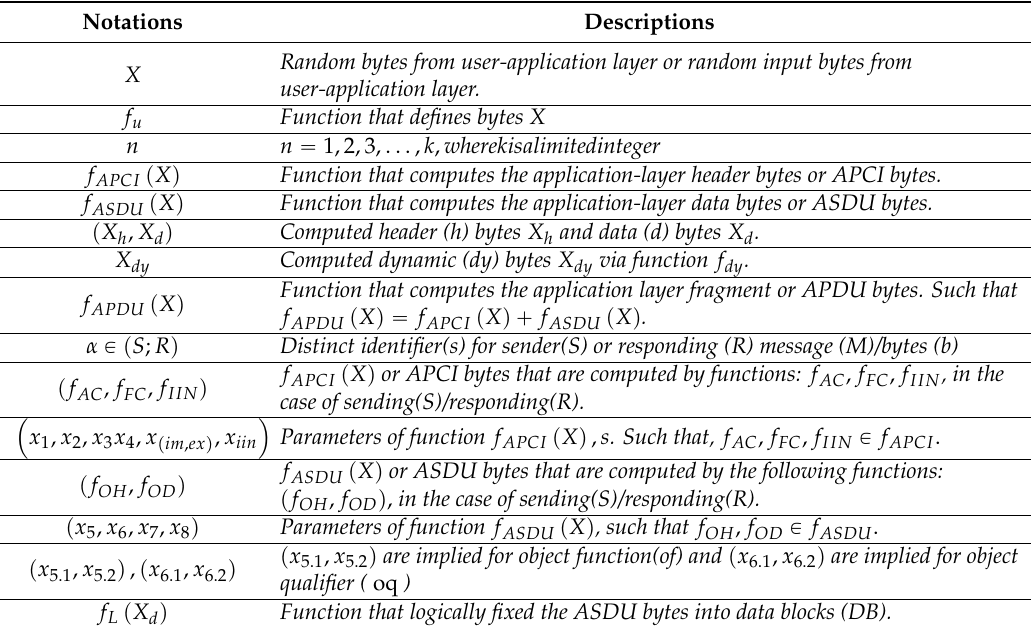
Table 1. Terminologies for system design and